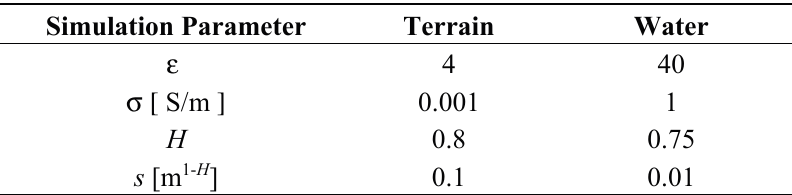
Table 3. Parameters used in the